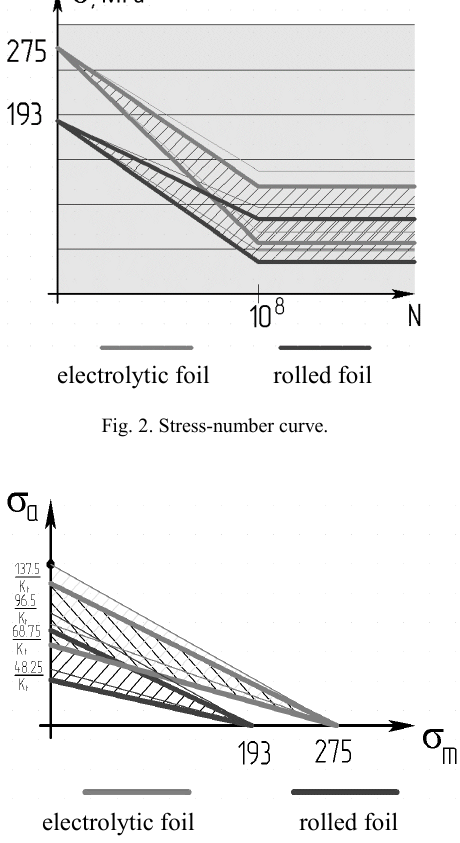
Fig. 3. Limiting amplitude